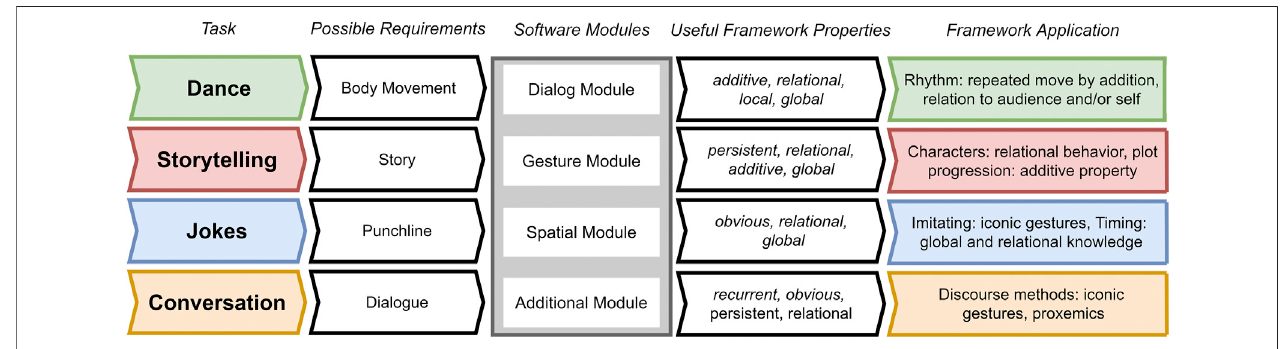
TABLE4| Possiblecombinationsofmovementtypes. comb. (green)are combinable movements, restr. (yellow)arecombinationsthatareonlypossibletosome restricted extent and excl. (red) are movements that are mutually exclusive .